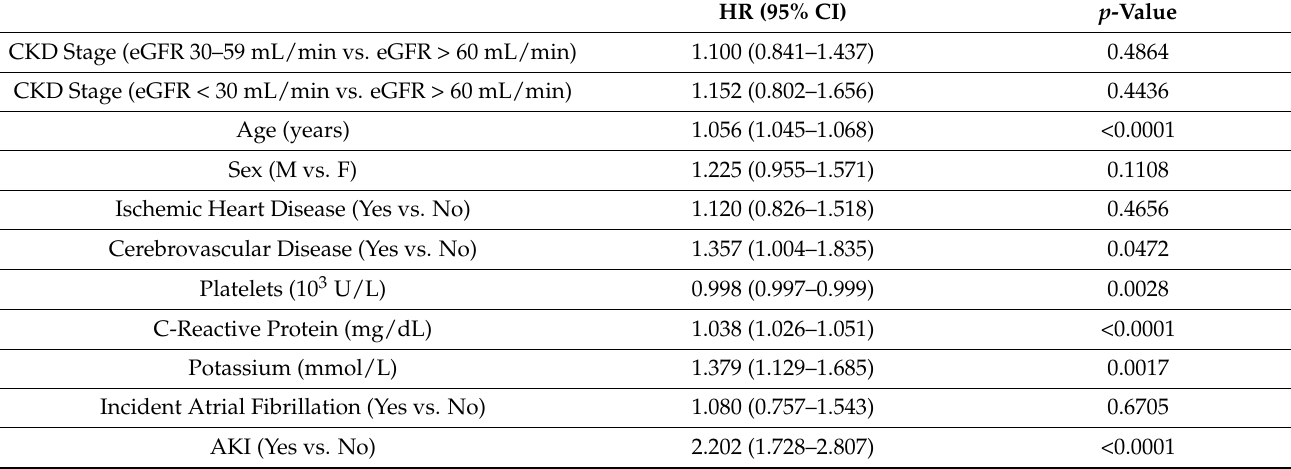
Table 3. Cox proportional hazards model on the effect of CKD on in-hospital mortality adjusted by age, sex, and selected clinical and laboratory variables, incident Atrial Fibrillation, and AKI. n = 2006, n of death = 327. HR (95%